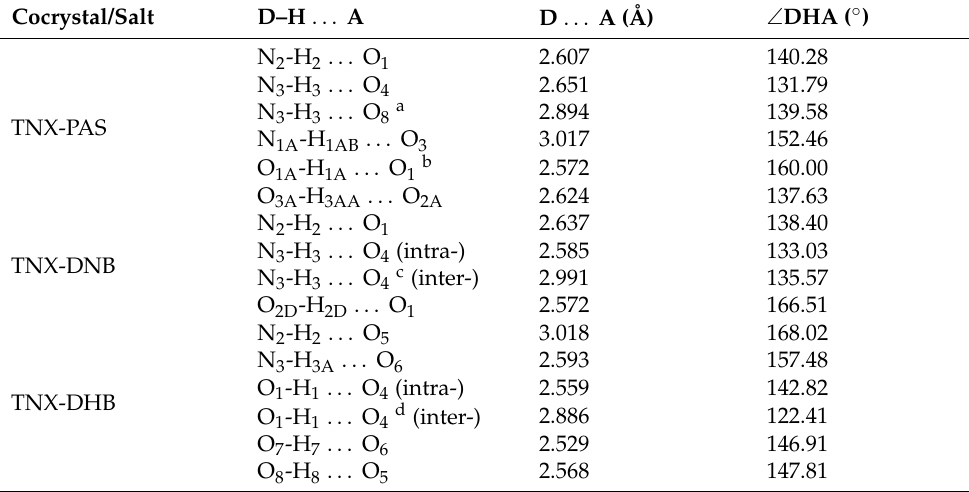
Table 3. Parameters (Å, ◦ ) of Main Hydrogen Bonds for Cocrystals and Salt of TNX.